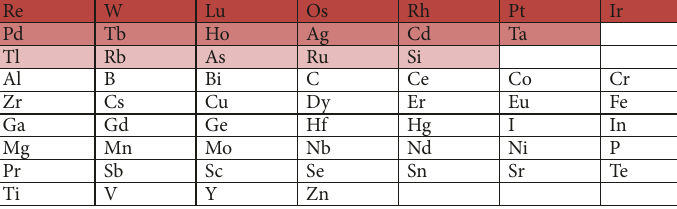
Figure 11: The elements whose effect on the thermal neutron spectrum due to inelastic scattering was examined.